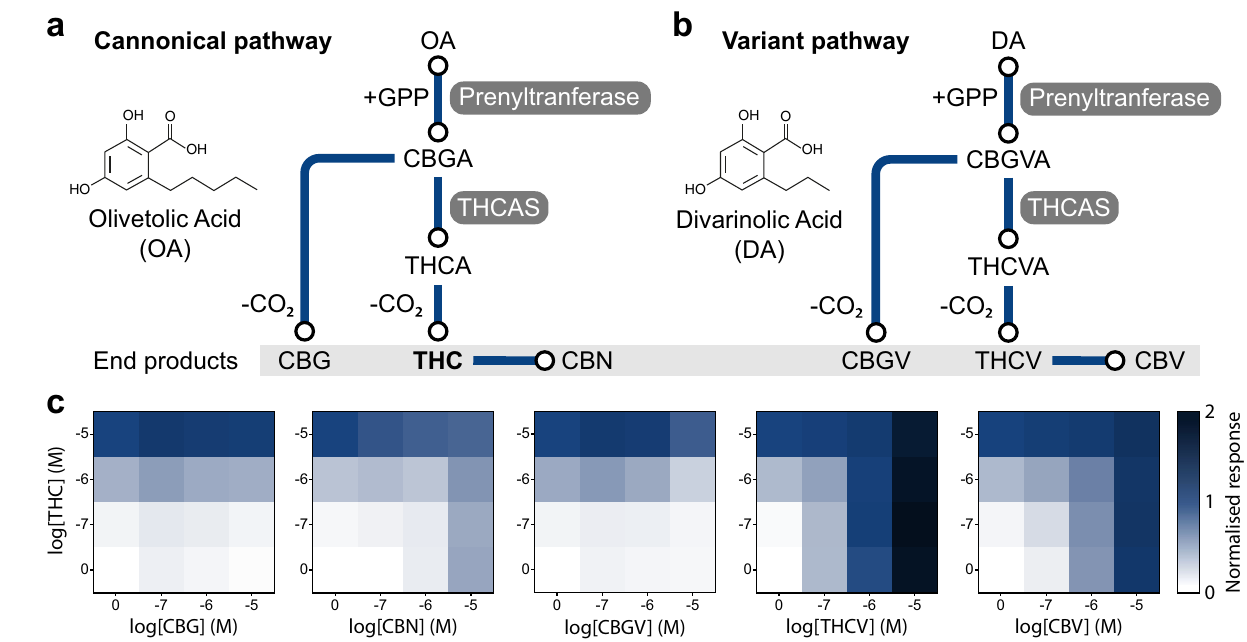
Fig. 4 | Measuring THC in the presence of pathway by-products. a Canonical cannabinoid biosynthesispathway showing the production ofcannabigerol (CBG), Δ 9 -tetrahydrocannabinol(THC),andcannabinol(CBN)fromtheolivetolicacid(OA) precursor. b Variant cannabinoid biosynthesis pathwayshowing the production of cannabigerovarin (CBGV), Δ 9 -tetrahydrocannabivarin (THCV), and cannabivarin